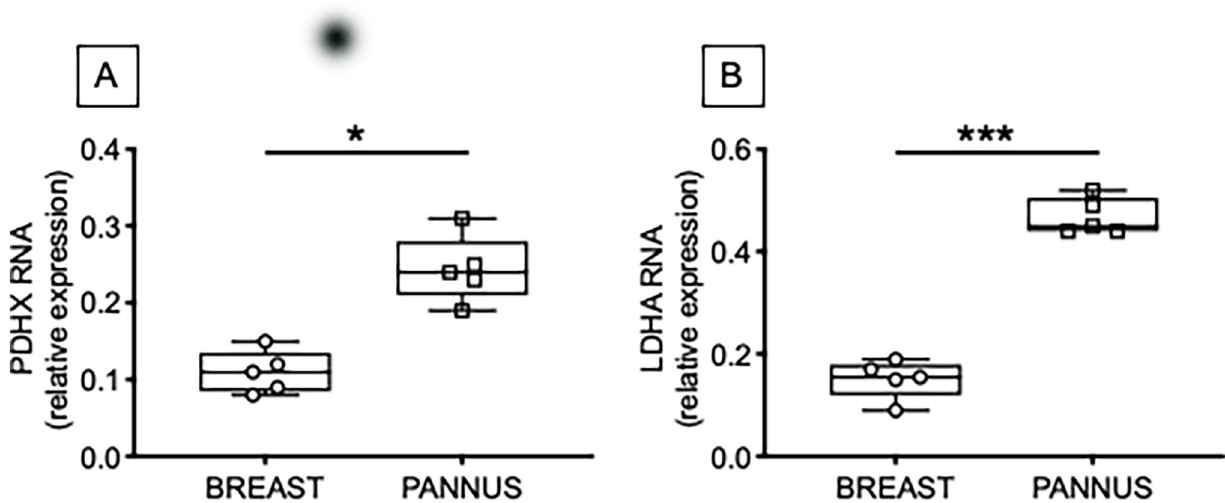
Fig 7. B cells sorted from the pannus, as compared to those sorted from the breast, express higher levels of RNA for PDHX and LDHA. B cells were isolated from pannus and breast SVFs using flow cytometry and cell sorting. After sorting, B cells were left unstimulated and resuspended in TRIzol for RNA expression of PDHX ( A ) and LDHA ( B ). Results show qPCR values of RNA expression of PDHX and LDHA, relative to GAPDH, calculated as 2 - Δ Cts . Mean comparisons between groups were performed by Student’s t test (two-tailed). * p < 0.05, *** p < 0.001. Each symbol represents an individual, n = 5 breast donors and n = 5 pannus